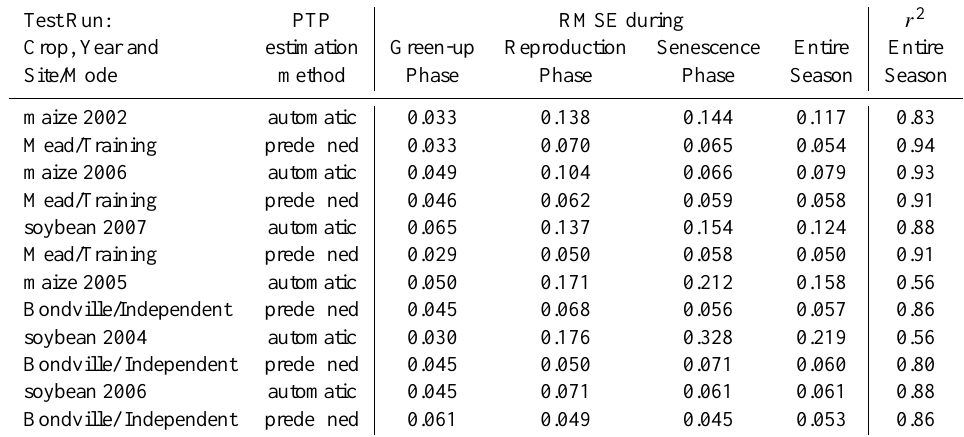
Table 5. EDPM performance simulating TNDVI dynamics under different testing regimes.